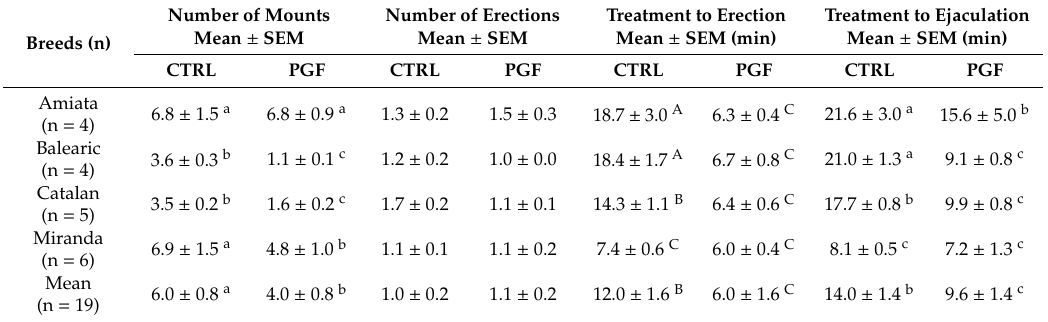
Table 2. Behavioral parameters in 106 semen collections performed in 19 jacks of di ff erent breeds (Amiata, n = 4; Balearic N = 4; Catalan n = 5; Miranda n = 6). In half of the collections, jacks were treated with 125 µ g of cloprostenol sodium (PGF) or 1 mL of saline (CTRL) prior to semen